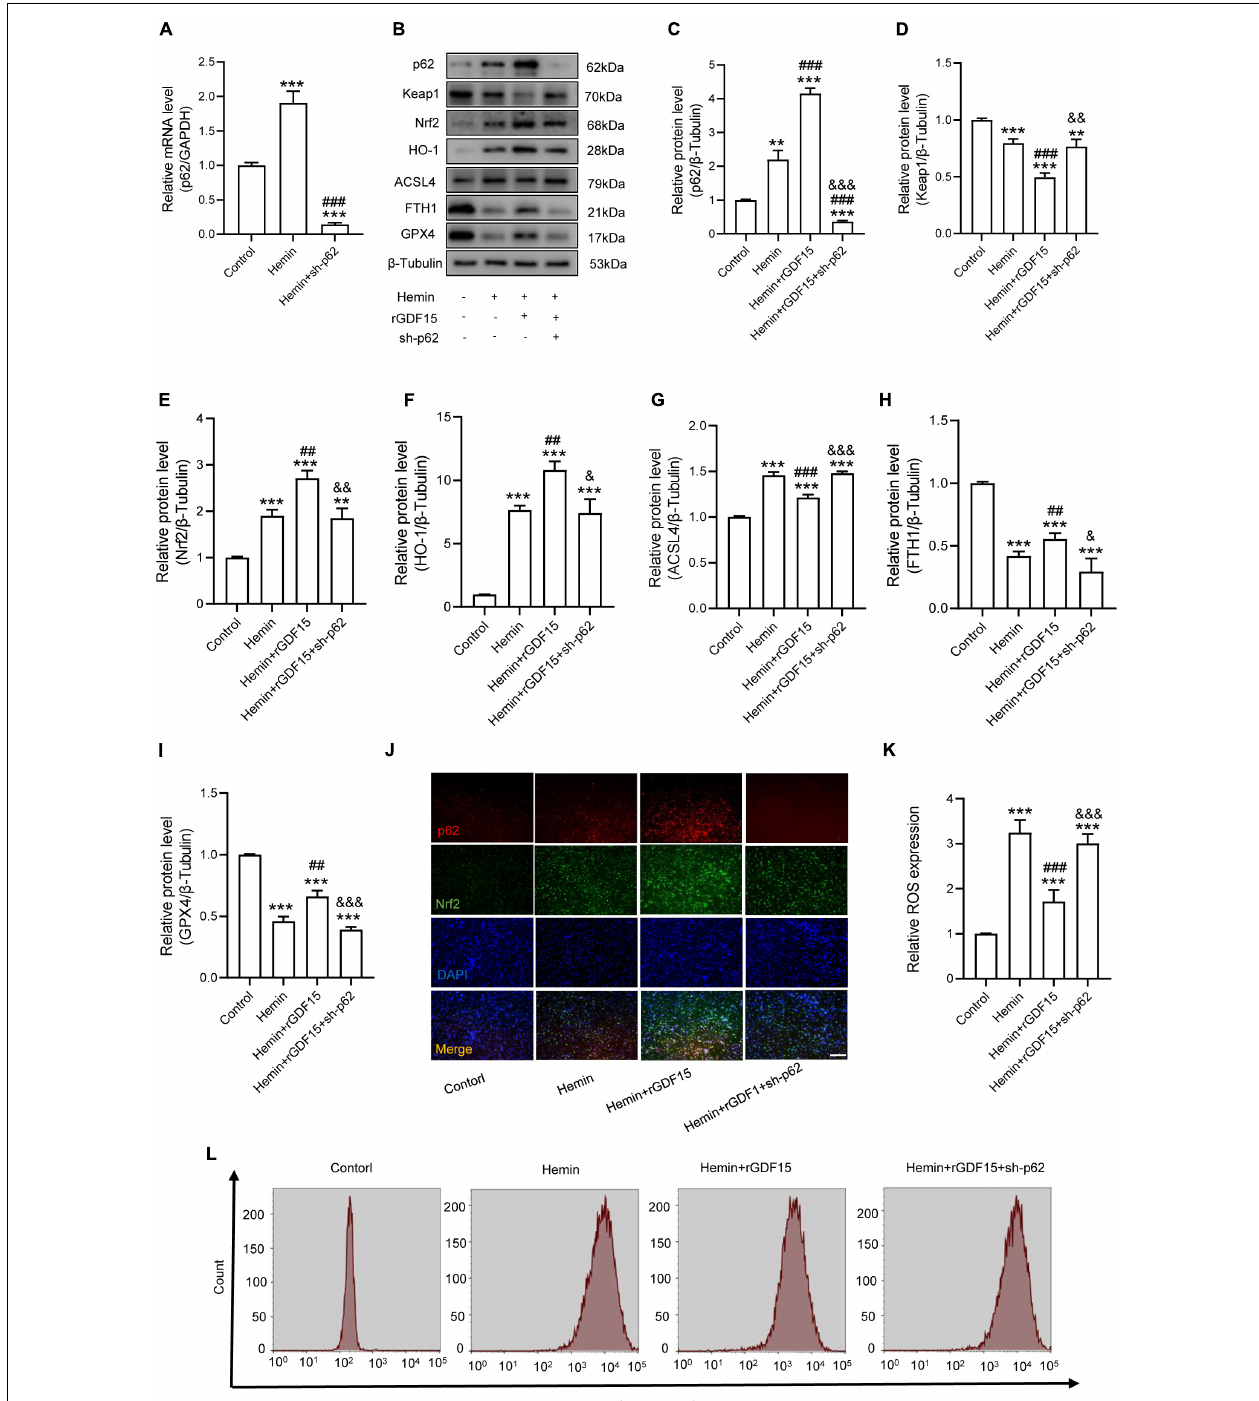
FIGURE 3 | GDF15 mitigates Hemin-induced ROS production and ferroptosis in neurons through the p62-Keap1-Nrf2 signaling pathway. (A) Relative mRNA level of p62 after knockdown ( n = 6). (B) Western blotting performed for p62, Keap1, Nrf2, HO-1, ACSL4, FTH1, and GPX4 in Hemin-activated primary neurons after adding rGDF15 or transfection of sh-p62 ( n = 3). β -Tubulin was used as the control. (C–I) Bar graph showing quantitative analysis of p62, Keap1, Nrf2, HO-1, ACSL4, FTH1, and GPX4 ( n = 3). (J) Representative immunofluorescence labeling images for p62 (red) and Nrf2 (green) in Hemin-activated primary neurons after adding rGDF15 or transfection of sh-p62 (Scale bar = 200 µ m). (K) Bar graph showing quantitative analysis of ROS expression ( n = 6). (L) The value of ROS was determined ( n = 6). The error bars represent the SD. ** p < 0.01, *** p < 0.001, vs. control group; ## p < 0.01, ### p < 0.001, vs. Hemin group; & p <